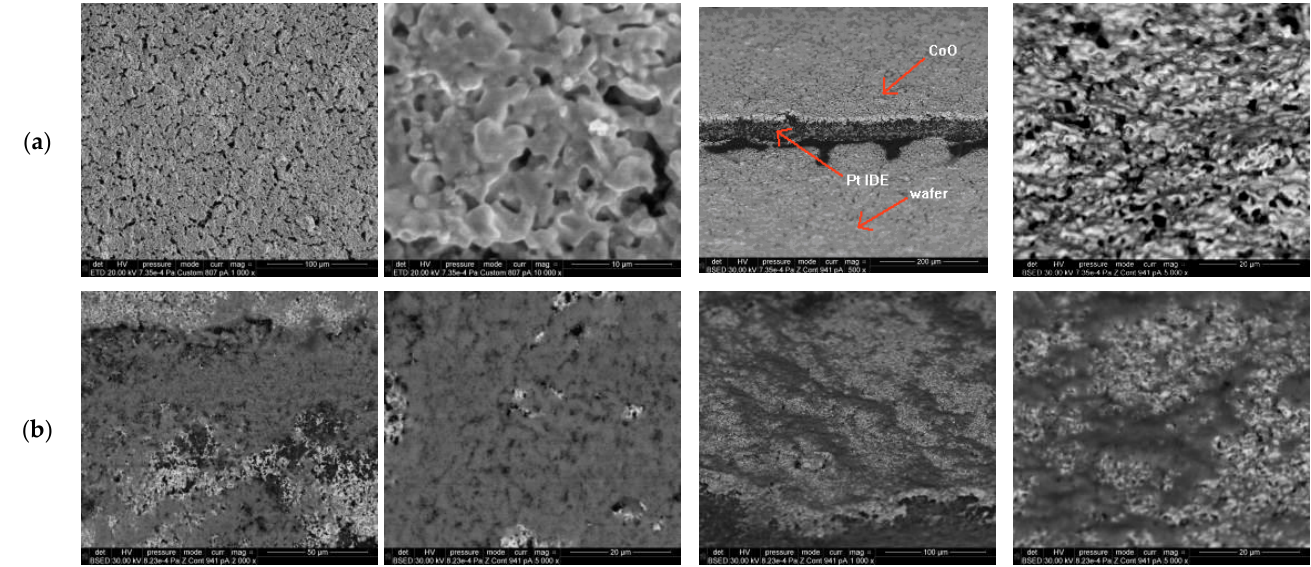
Figure 2. SEM images of: ( a ) CoO sensitive film; ( b ) CuO sensitive film, at different magnification factors; last two images of each group ( a and b ) are tilted.